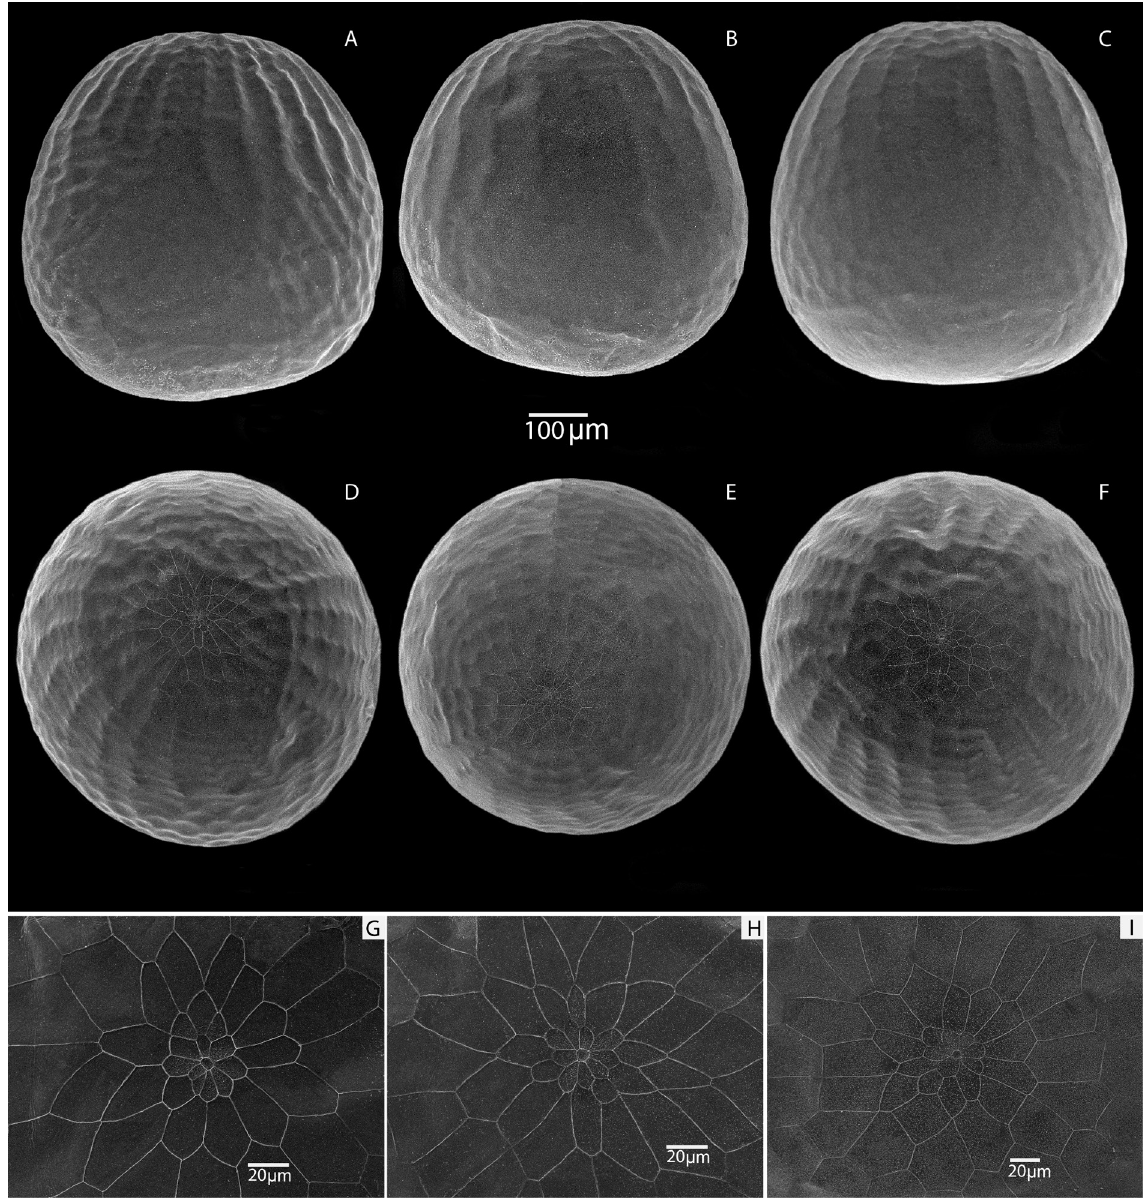
Fig. 7. Eggs of Melitaea mimetica Higgins, 1940, Afghanistan, Ghor Prov., 16 km E of Changcharan, Bandi-Ali v. vicinity, alt. 2400 m. A–C . Lateral view. D–F . View from above. G–I . Micropile